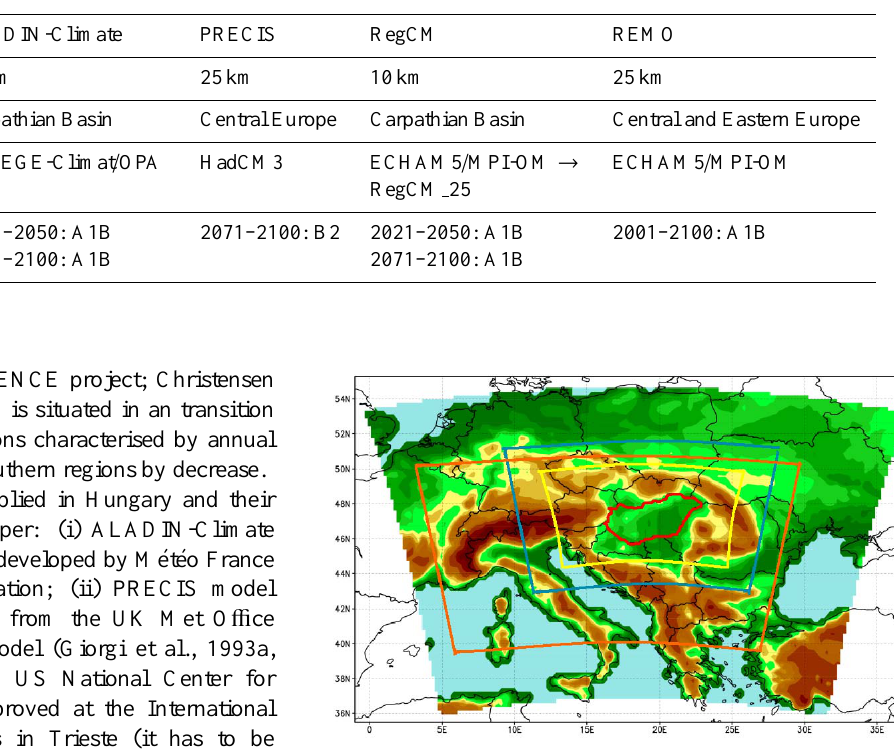
Table 1. Main characteristics of the simulations.